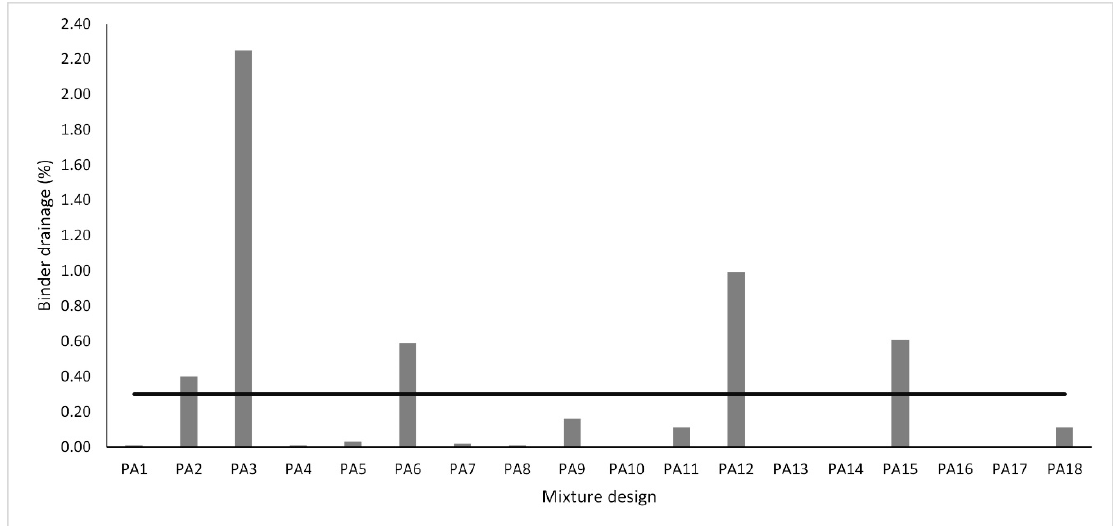
Figure 12. Binder drainage results according to the mesh basket drain down test.